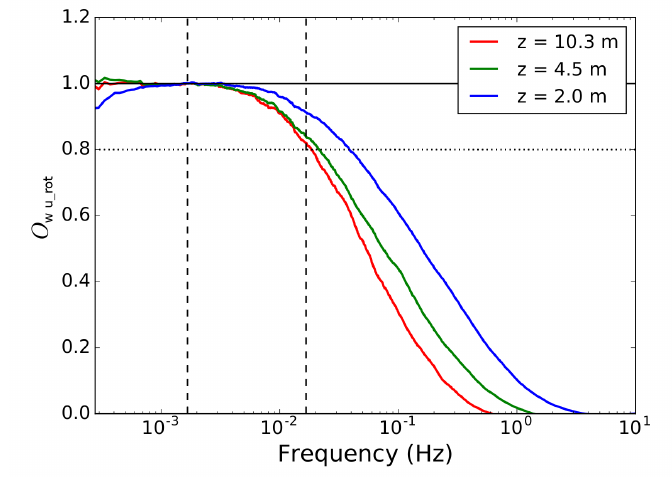
Figure 8. Results of the ogive test between vertical w and the horizontal u rot wind components using all observations from the three tower heights during the period 10 February 2018 14:30–22:00 UTC. Ogives are normalized by the value at the point closest to the frequency corresponding to 10 min, indicated by the first vertical dashed line from left. The second vertical dashed line represents the frequency corresponding to 60